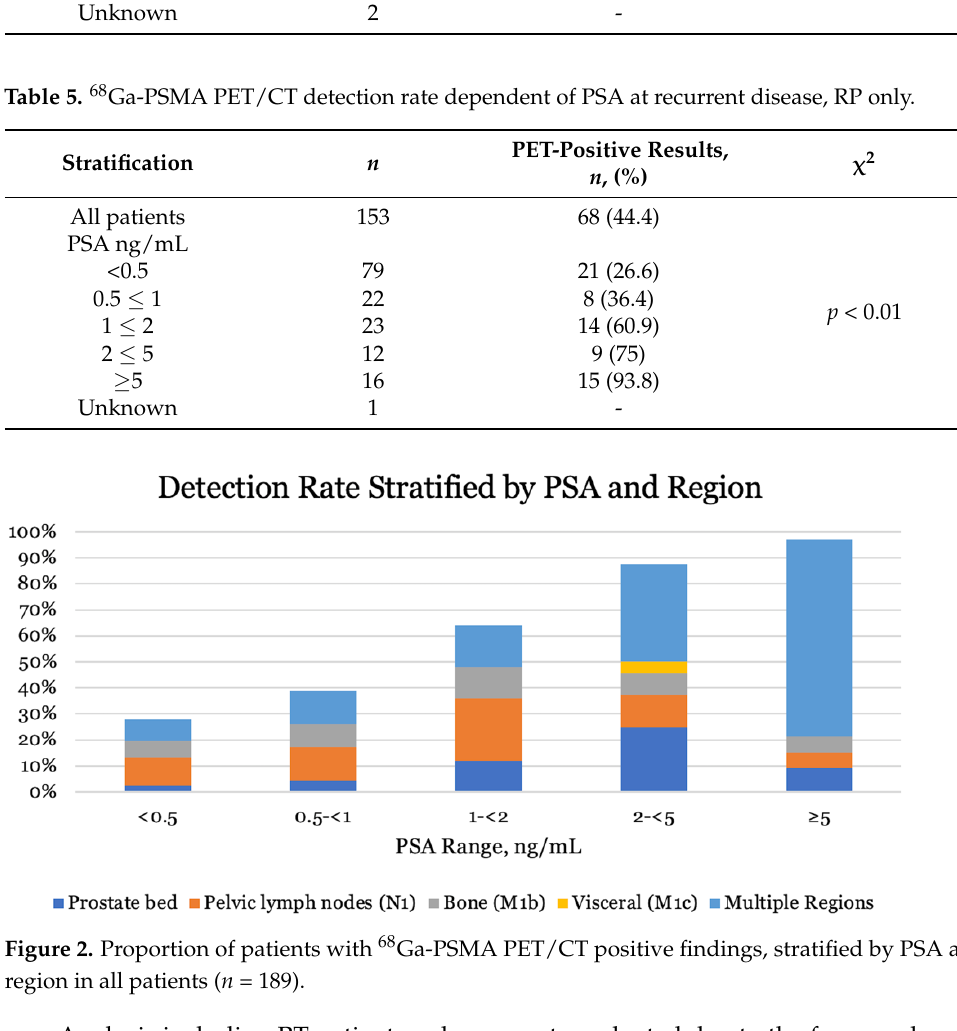
- Table 5. 68 Ga-PSMA PET/CT detection rate dependent of PSA at recurrent disease, RP only. Stratification